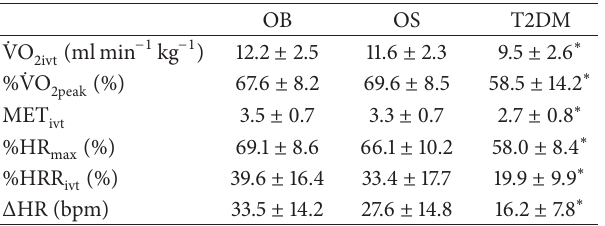
Table 3: Absolute and relative exercise intensities at IVT in obese, sarcopenic obese, and T2DM